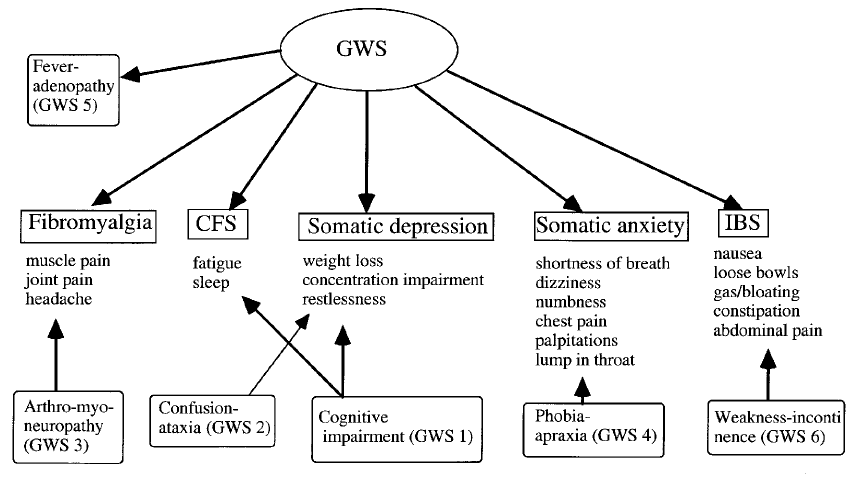
Fig. 1. GWS: single or multi-faceted